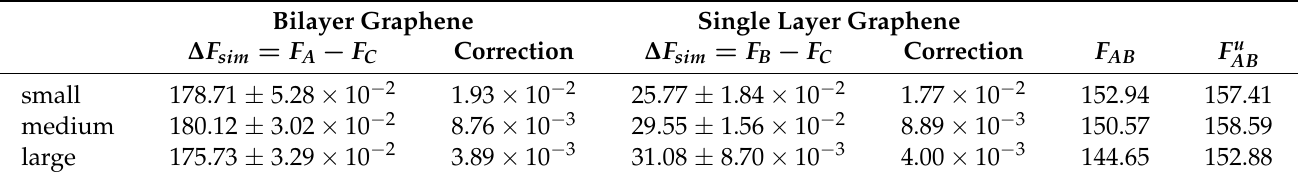
Table 2. Differences of free energy by decoupling bilayer, F A − F C , and single layer, F B − F C , graphene samples with small, medium and large size. The free energy variance ( ± σ ) is given by the average of the variances over the 31 λ steps. Correction is computed by kTln ( V λ = 1 / V λ = 0 ) . F AB is the exfoliation free energy expressed by ( F A − F C ) − ( F B − F C ) . F u is the exfoliation free energy for the corresponding bilayer graphene samples computed using umbrella sampling in a previous work [40]. The energies are normalized by the area of the graphene layers, expressed in kJ mol − 1 nm − 2